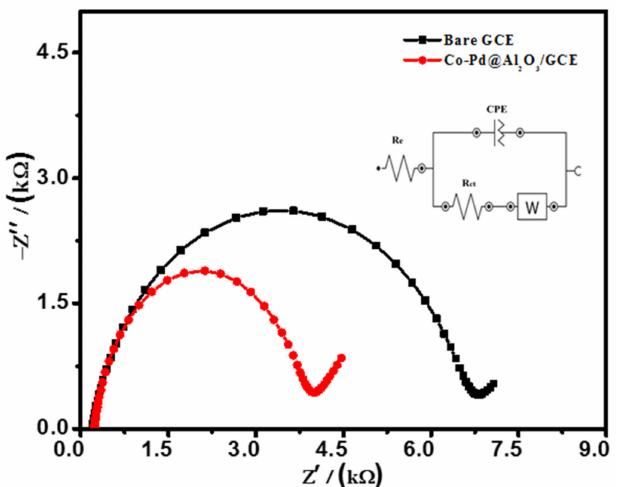
Figure 5. Nyquist plots for bare GCE and Co–Pd@Al 2 O 3 /GCE in the 5 mM solution of the